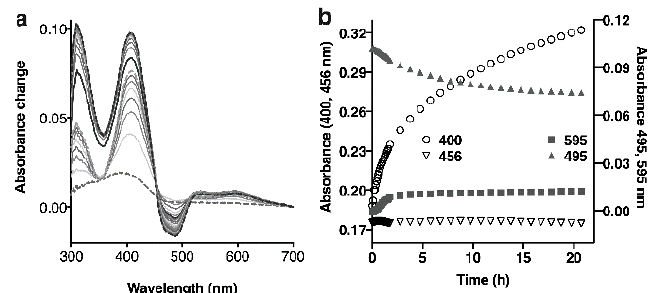
Molecules 2019 , 24 , x 16 of 26 Figure 10. Orientation and movement of selegiline and its allenyl product in the active site of MAO- B. ( A ) Oxidized MAO-B with selegiline; ( B ) reduced MAO-B with the allenyl-imine product from selegiline oxidation . Left: interactions in the active site; Middle: atom plot distances of the α -carbon to N5 of FAD (top) or imine C-terminal to N5-FADH − (bottom); Right: the angle to FAD or FADH — . 2.5. F2MPA is Anomalous 2.5.1. F2MPA Interaction with MAO-A The kinetic traces in Figure 7 show that F2MPA is a very poor inactivator of MAO-A, so more work was done to find out why. MAO-A incubated anaerobically for 21.5 h with 0.5 mM F2MPA retained only 7% activity, but overnight aerobic dialysis restored activity to 88%, indicating that minimal covalent adduct had been formed. The slow dissociation suggests tight binding in the complex formed in the absence of oxygen. F2MPA slowly reduced MAO-A under anaerobic conditions, so it is a very poor substrate (Table S2). It also induced an absorbance increase at 600 nm, suggesting a charge transfer complex not seen with any of the other inactivators. The time courses for the relevant wavelengths are shown in Figure 11. In order to find a cause for the 600 nm absorbance, we considered whether oxidation could occur at either carbon adjacent to the amine nitrogen in MAO-A. (MAO-B is inactivated by F2MPA [19], so presumably, the normal allenyl imine